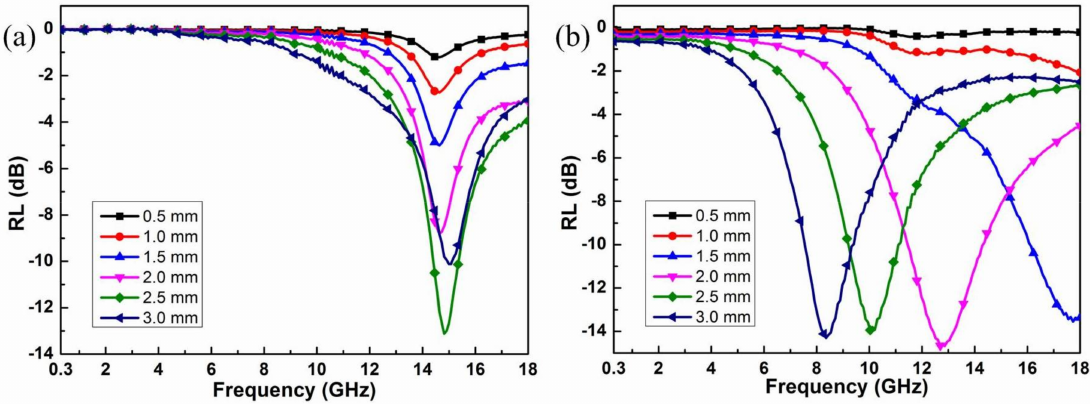
Figure 5. The calculated reflection loss: ( a ) Co 0.5 Ni 0.5 Fe 2 O 4 fibers; ( b ) Co 0.5 Ni 0.5 Fe 2 O 4 fibers/RGO.